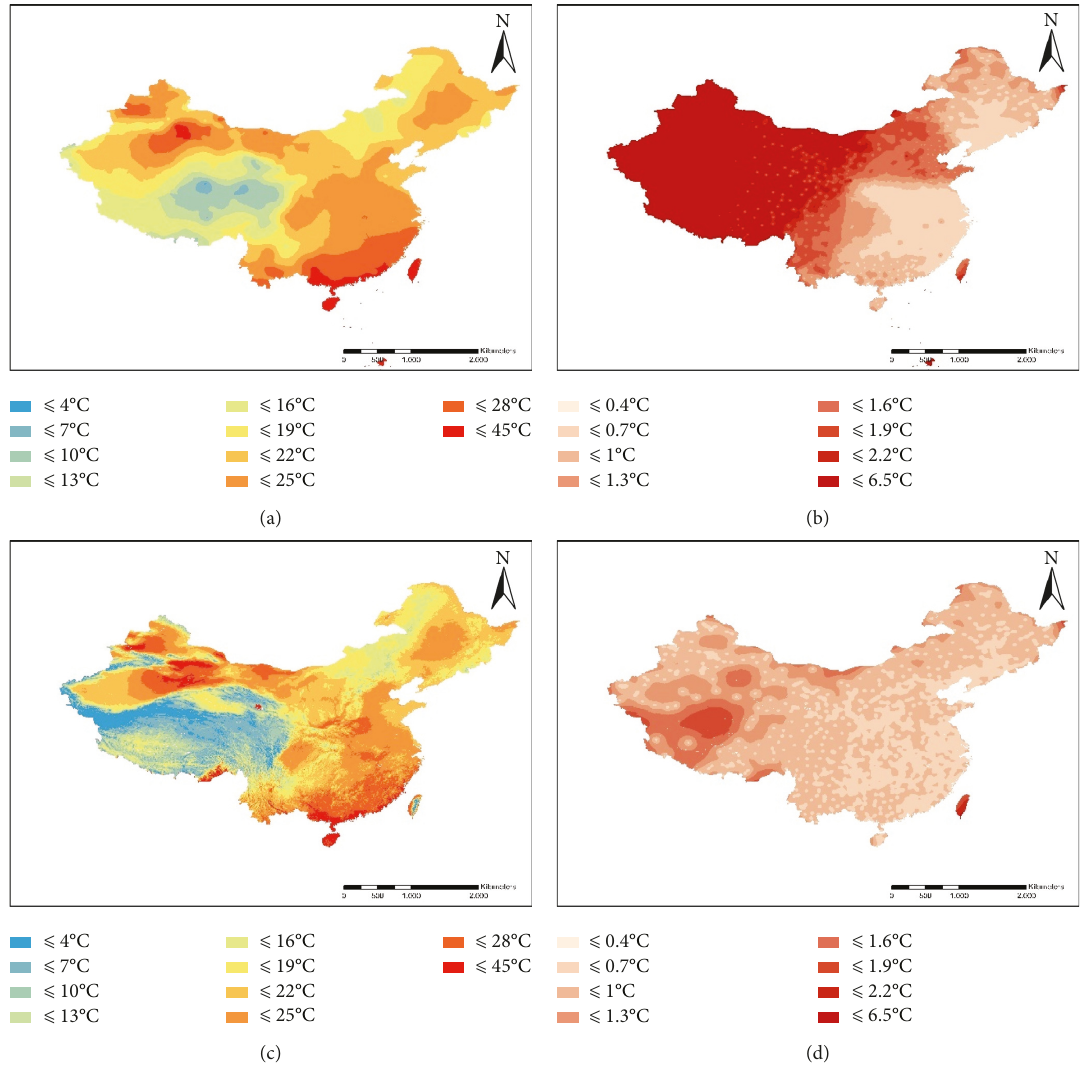
Figure 7: SS interpolation maps of T a -mean with (a) BME-hard and (c) BME-both. (b, d) The corresponding prediction standard error